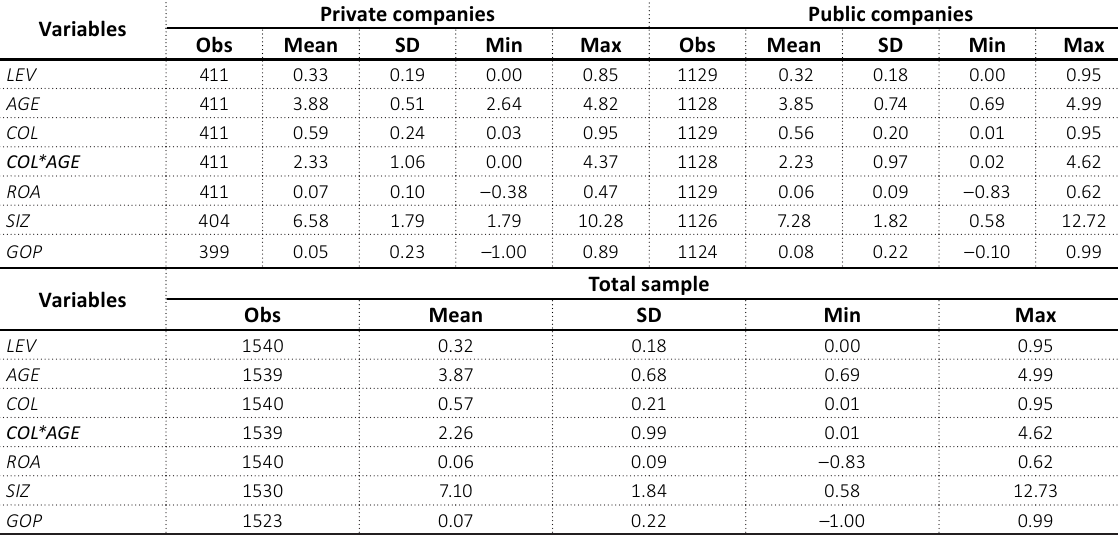
Table 3. Descriptive statistics of